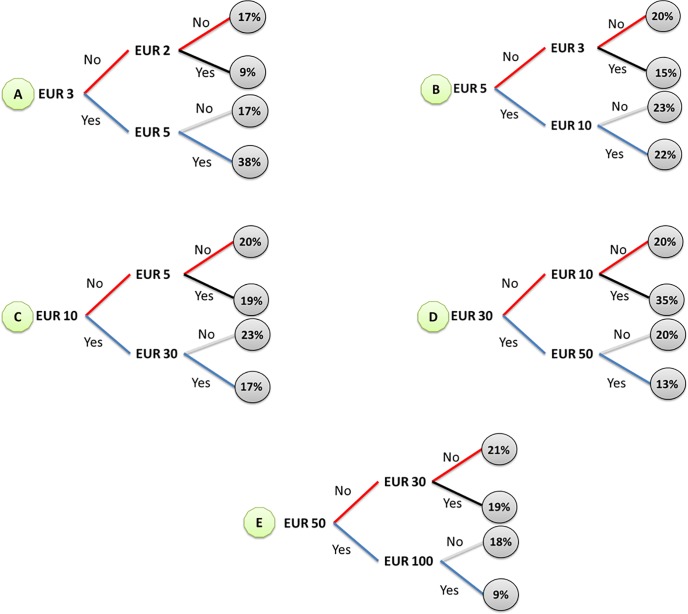
Percentage distribution of the WTP answers by triple combination of bids.The distribution is net of protest answers and outliers (N = 965). Letters A, B, C, D, and E in light green denote the version of the questionnaire; answers paths are: “No-no” (red); “no-yes” (red-black); “yes-no” (blue-light grey), “yes-yes” (blue). Grey circles display percentages.